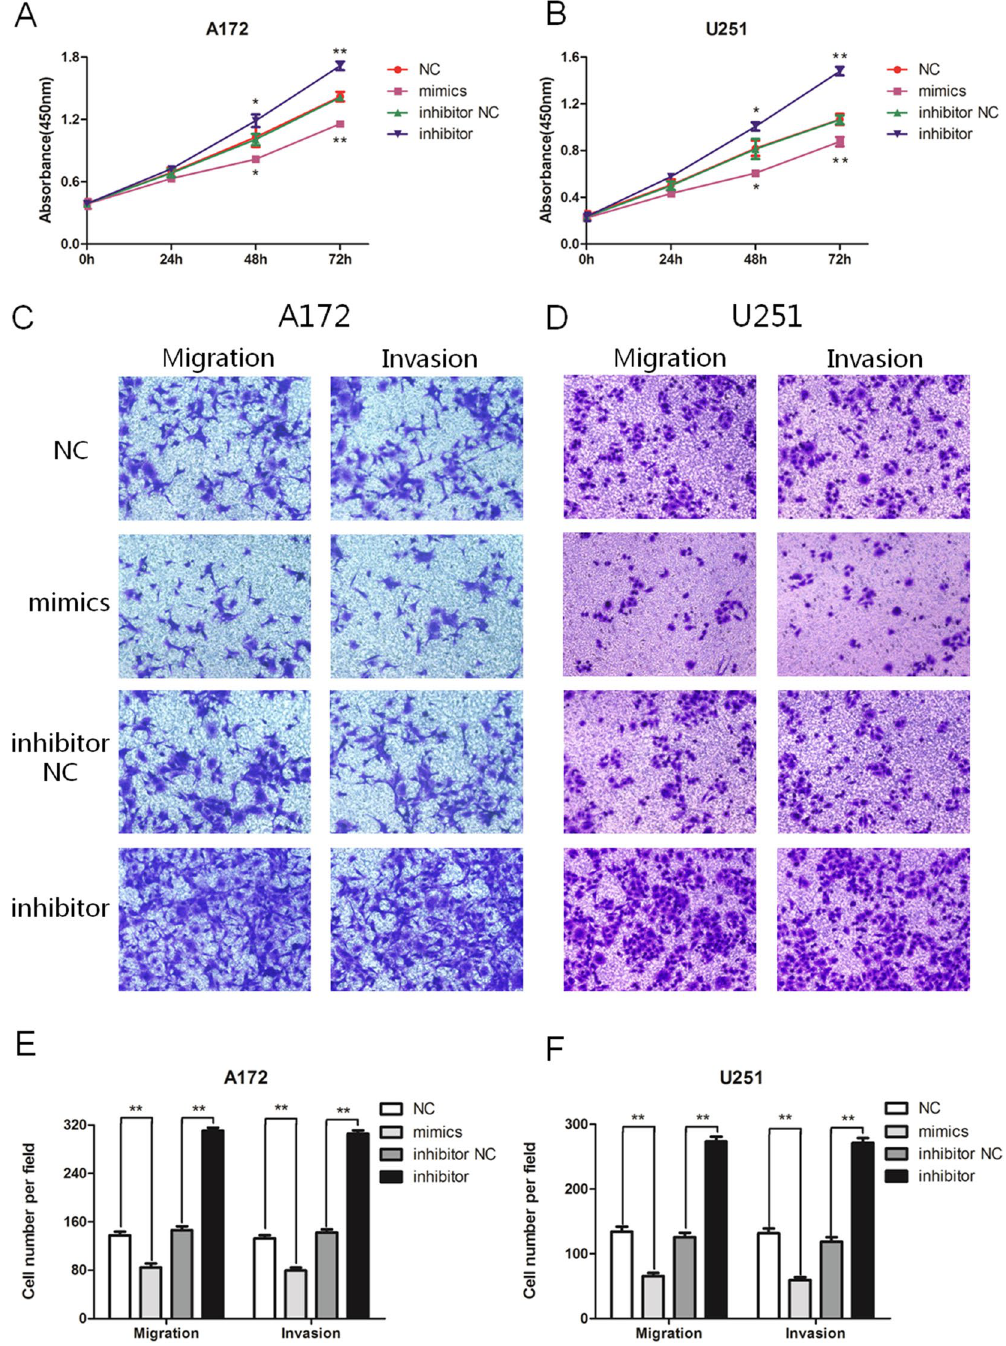
Figure 3. miR-30c reduces the proliferation, migration, and invasion of glioma cells. ( A , B ) CCK8 assay revealed that miR-30c could impact the proliferation of A172 and U251 cells (* P < 0.05, ** P < 0.01). ( C , E ) The migration and invasion of the mimics and inhibitor groups were significantly changed in A172 cells (** P < 0.01). ( D , F ) The migration and invasion of U251 cells were significantly changed after transfection with the mimics and the inhibitor (** P <